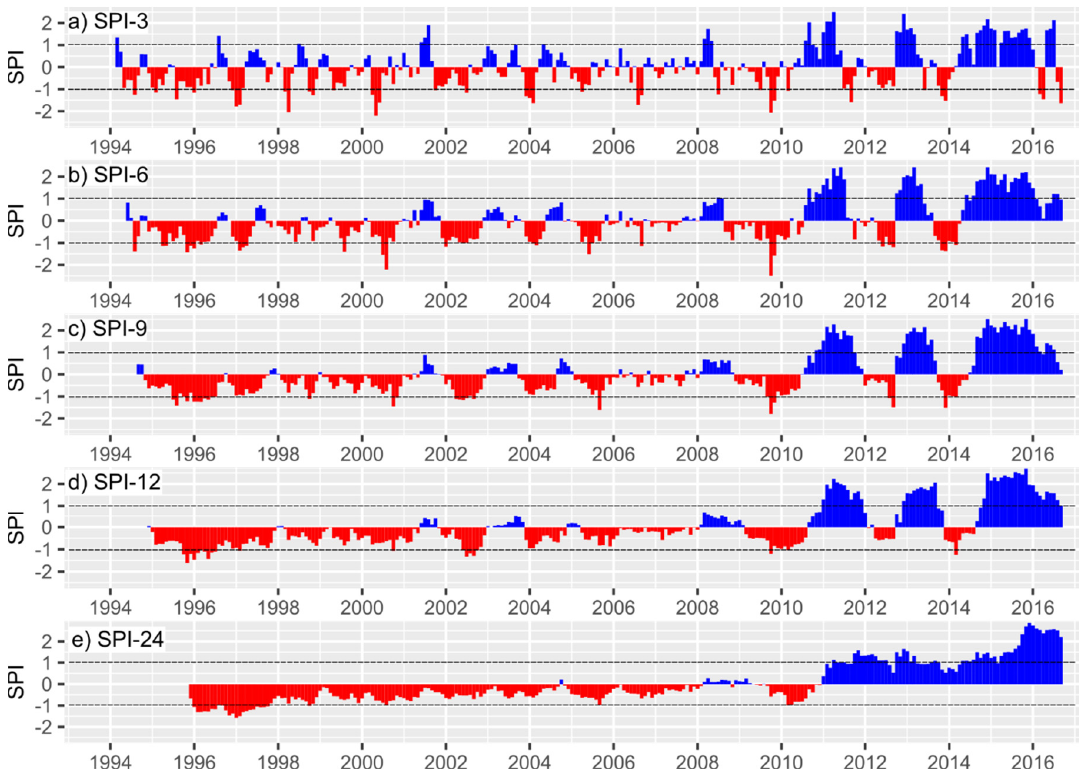
Figure 4. Standardized Precipitation Index (SPI) calculated for the time scales of ( a ) 3, ( b ) 6, ( c ) 9, ( d ) 12 and ( e ) 24 months for the period of 1994 to 2016 for Anuradhapura weather station. SPI classification according to [24] (Table 3). Blue bars mark SPI values > 0, red bars mark SPI values < 0. SPI values between 0.99 and − 0.99 (area between the dashed lines) are classified as near normal conditions.